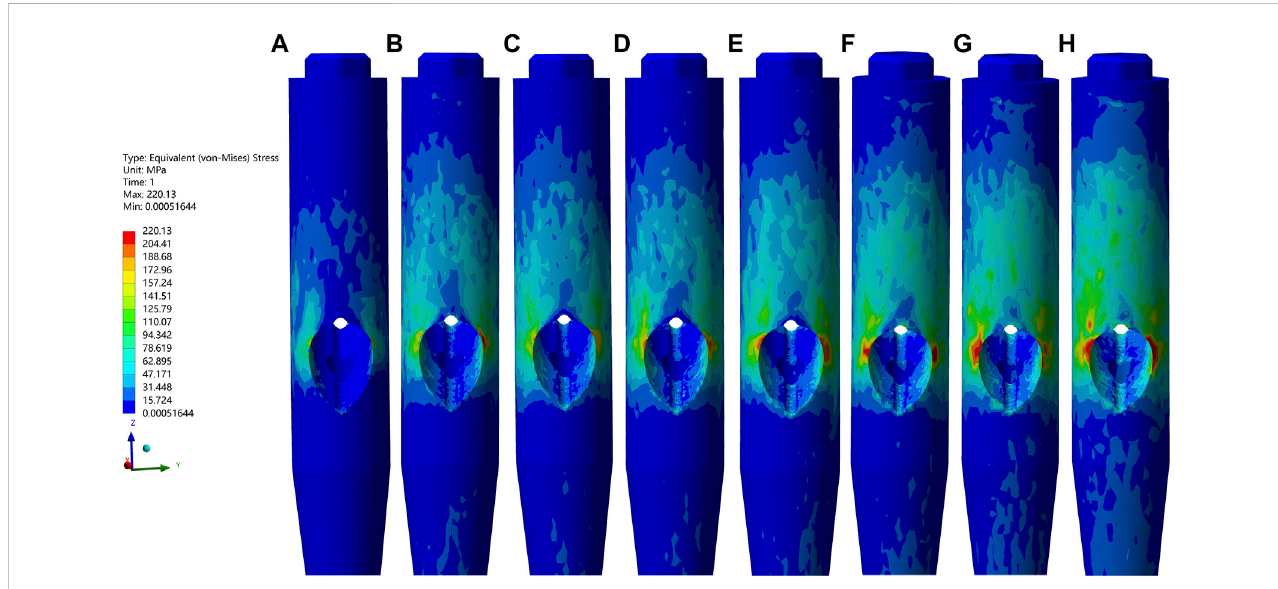
FIGURE 4 TheVMSvaluesandnephogramsoftheIMnailsunderthedynamicclimbinghiploadwereexhibited. (A – H) indicatedthebasicfracturelinemodel,thePL wall defect model, the AL, the PM, the L, the PML, the AM, and the M wall defect model, respectively. From images (A – H) , the peak value of each IM model gradually increased and the highest one of 220.13 MPa appeared in (H) .